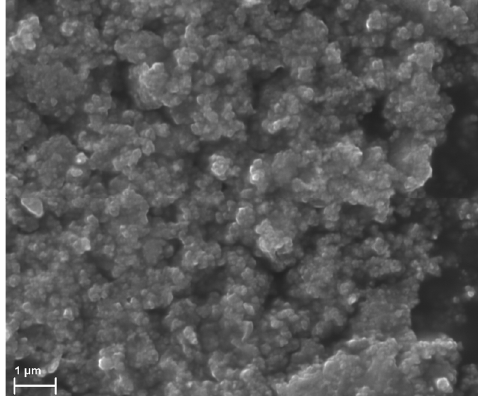
Figure 1. SEM image of ACN fraction after grinding with a bead mill.